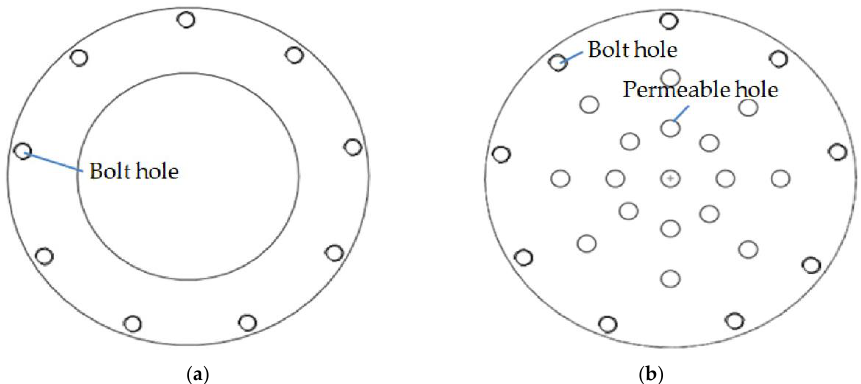
Figure 2. The bottom form. ( a ) Annular tray; ( b ) circular-hole chassis.